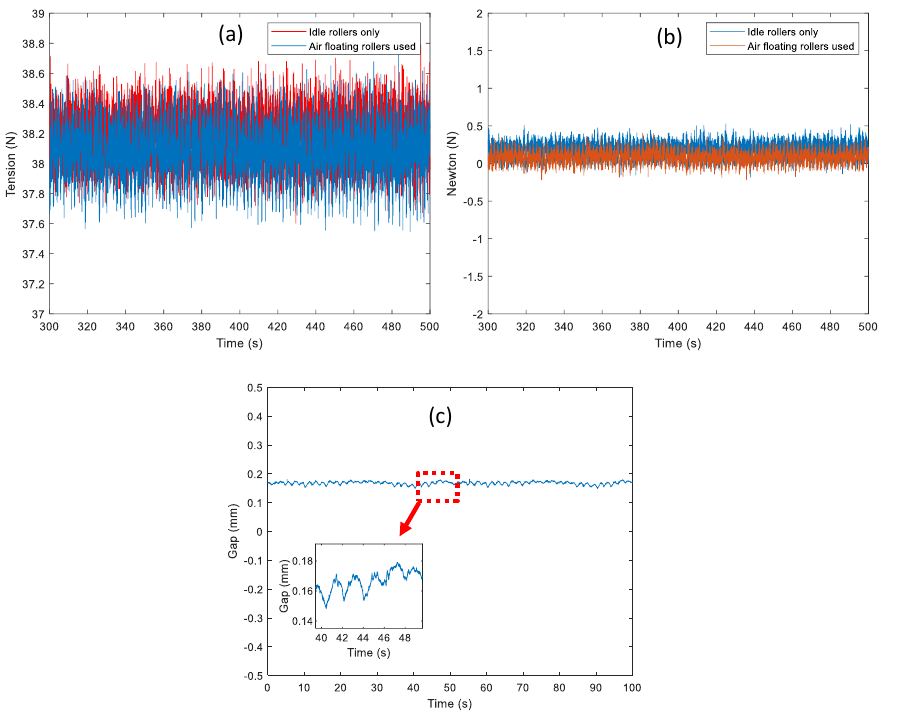
Figure 13. Comparison of the control performance between the idle roller only and the air floating roller used: ( a ) tension measurement of the unwinder module (tension feedback), ( b ) tension differ- ence between the unwinder and rewinder module and ( c ) air gap measurement between the web and roller using the confocal